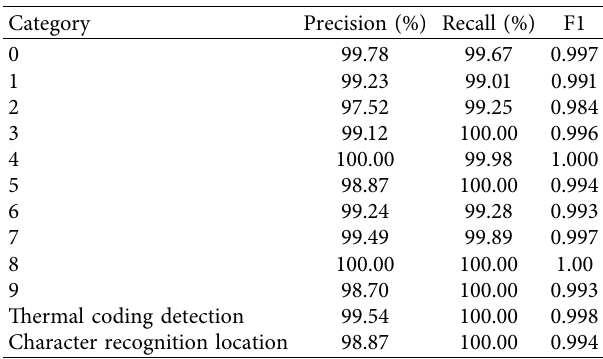
Table 5: Lightweight YOLO test